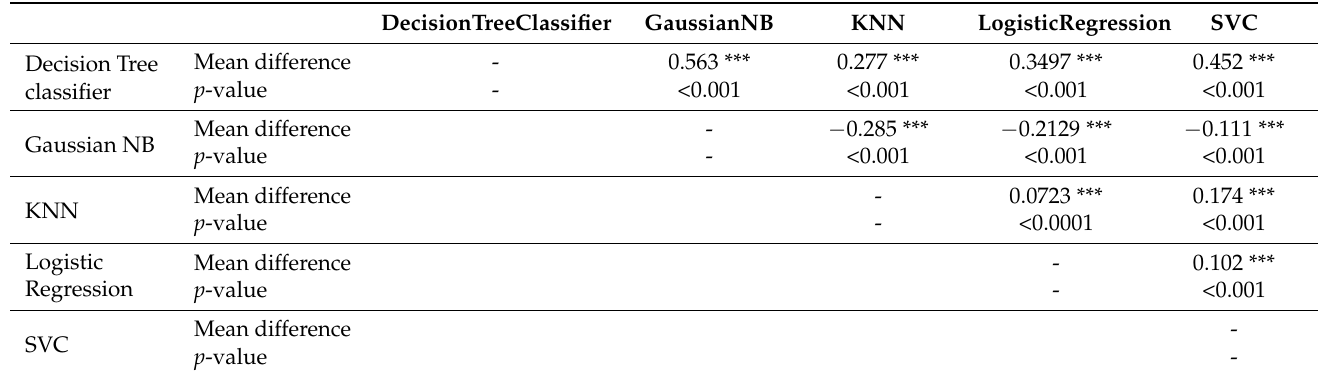
Table A5. The results of the Games–Howell post hoc test on test MCC.